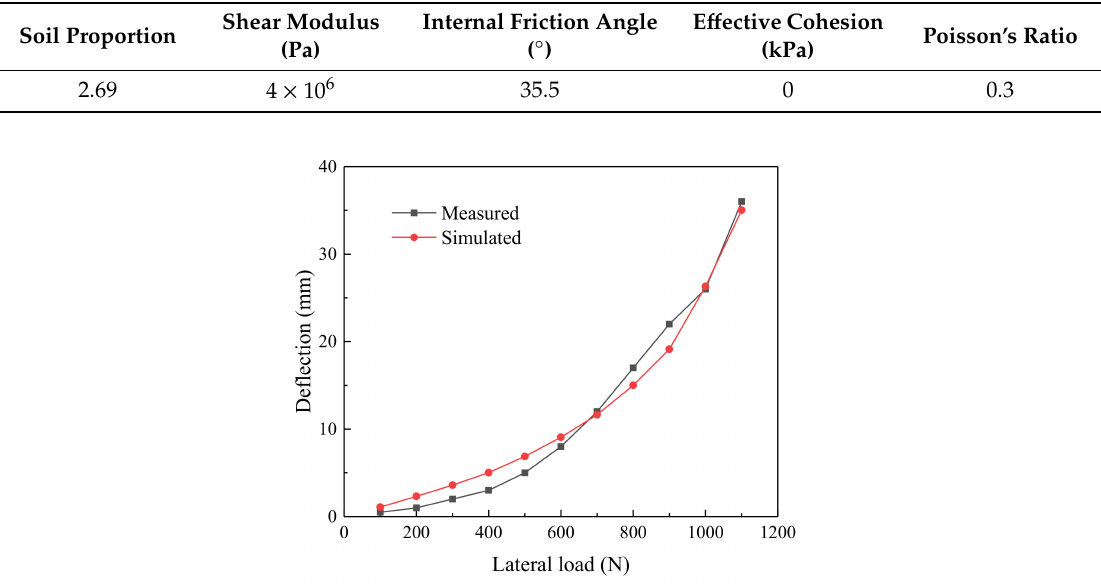
Table 2. Parameters of testing soil.